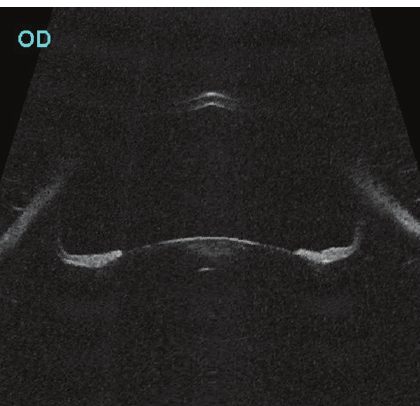
Figure 1: Ultrasound biomicroscopy (axial scan) of the right eye showing hyperdeep anterior chamber with prominent posterior bowing of midperipheral iris with crystalline lens touching the iris.